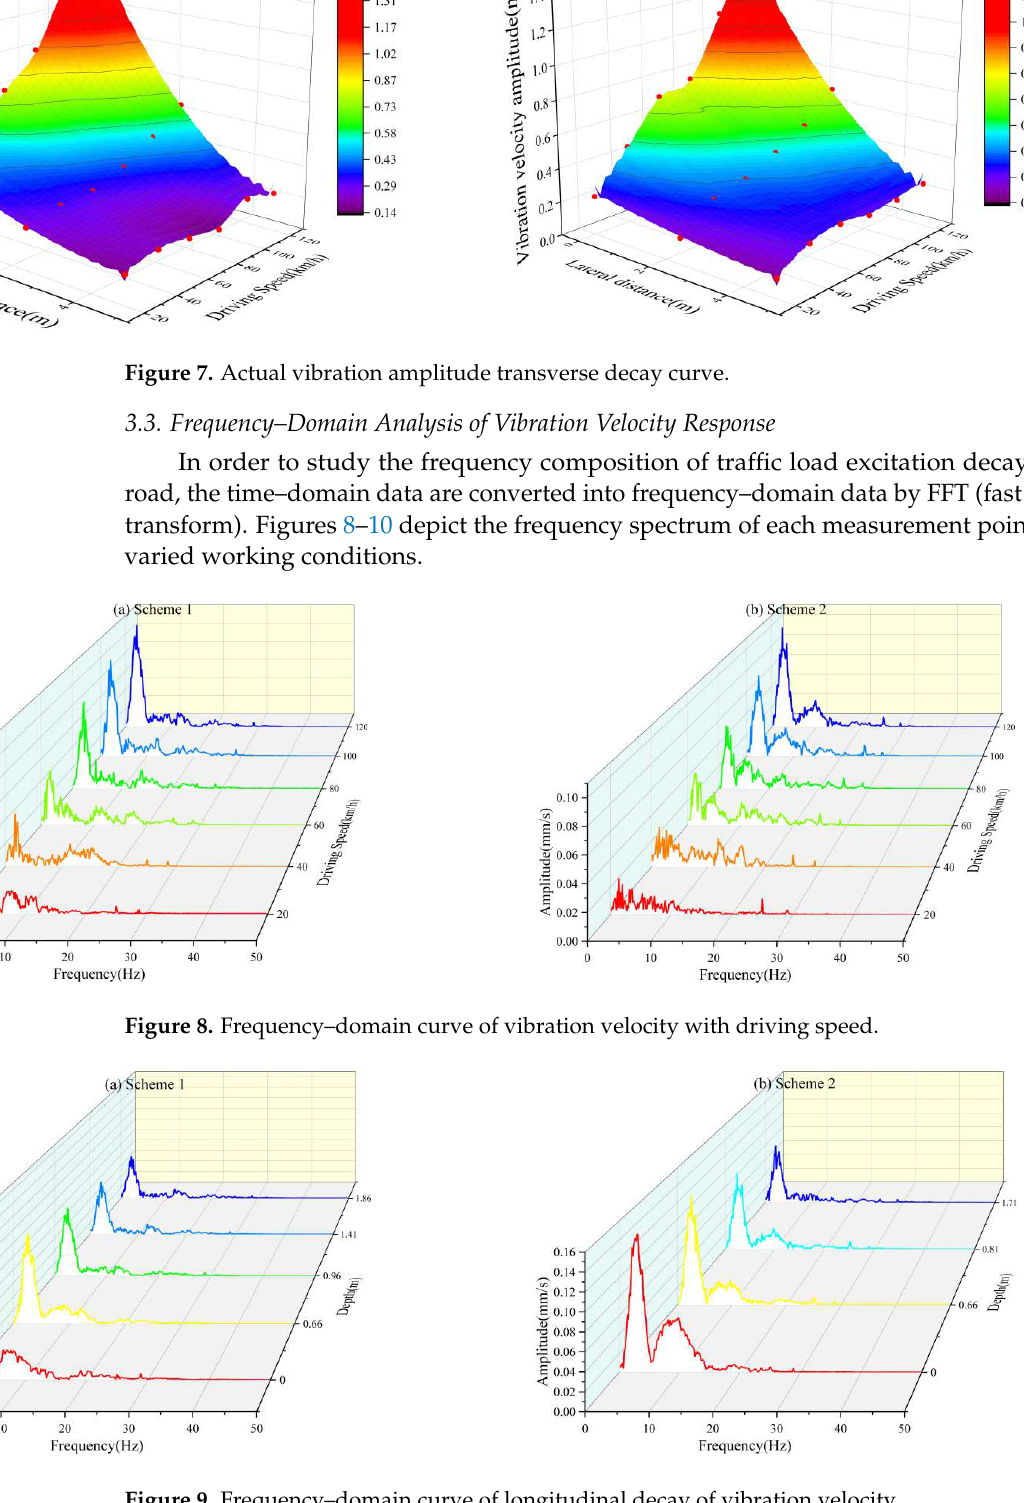
Figure 10. Vibration velocity level decay frequency–domain curve. 3.4. One-Third Frequency Range Analysis One-third frequency range analysis was used to explore the decay law of distinct frequency bands of vibration velocity with varying excitation and position changes. The energy distribution in various frequency ranges was also investigated [43]. The boundary frequencies of the 1/3 frequency range are calculated by the nominal value method, and the 1/3 frequency range diagram as shown in Figures 11–13 is obtained. Figure 11 demonstrates that each vibration frequency band decays with depth for a 100 km/h traveling test vehicle. The center frequency is divided into three bands with 5 Hz and 31.5 Hz as the boundary of the fundamental vibration frequency. The first band, 1–5 Hz, is mountainous with a noticeable peak, and as the depth increases, the peak shows a trend of decay. The frequency band is the test vehicle’s principal influence band. In this band, attenuation of vibration in gravelly soil is more negligible than that of geocell-reinforced aeolian sand. At 2 Hz, the amplitude of vibration from the upper surface to the lower surface of gravelly soil increases. It results from the phase change caused by the heteroge- neity of gravelly soil [44,45]. The second band, 5–31.5 Hz, has apparent fluctuations on the pavement surface. In addition, the vertical attenuation is faster than in the first segment. This frequency band’s vibration velocity accounted for a pretty considerable amount of the pavement’s attenuation. Scheme 2′s attenuation is more pronounced than scheme 1′s. The geocell-reinforced aeolian sand layer on the pavement structure of the vibration dif- fusion effect is greater than the gravelly soil. The third section is greater than 31.5 Hz. This vibration section hardly varies with depth, indicating that the road excitation of a me- dium-sized bus is within 31.5 Hz. As frequency increases, longitudinal attenuation tends to accelerate. The faster the frequency of vibration, the greater the number of vibrations of the corresponding masses and the increased energy dissipated inside the soil [46,47].